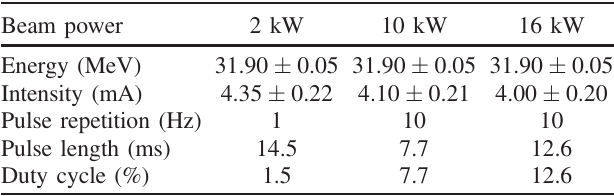
TABLE III. Beam parameters for the beam power ramp-up. Beam power